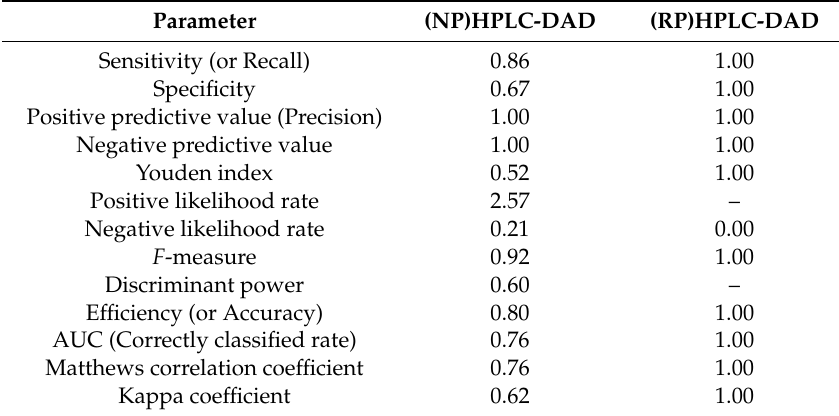
Table 7. Quality metrics of the PLS-DA